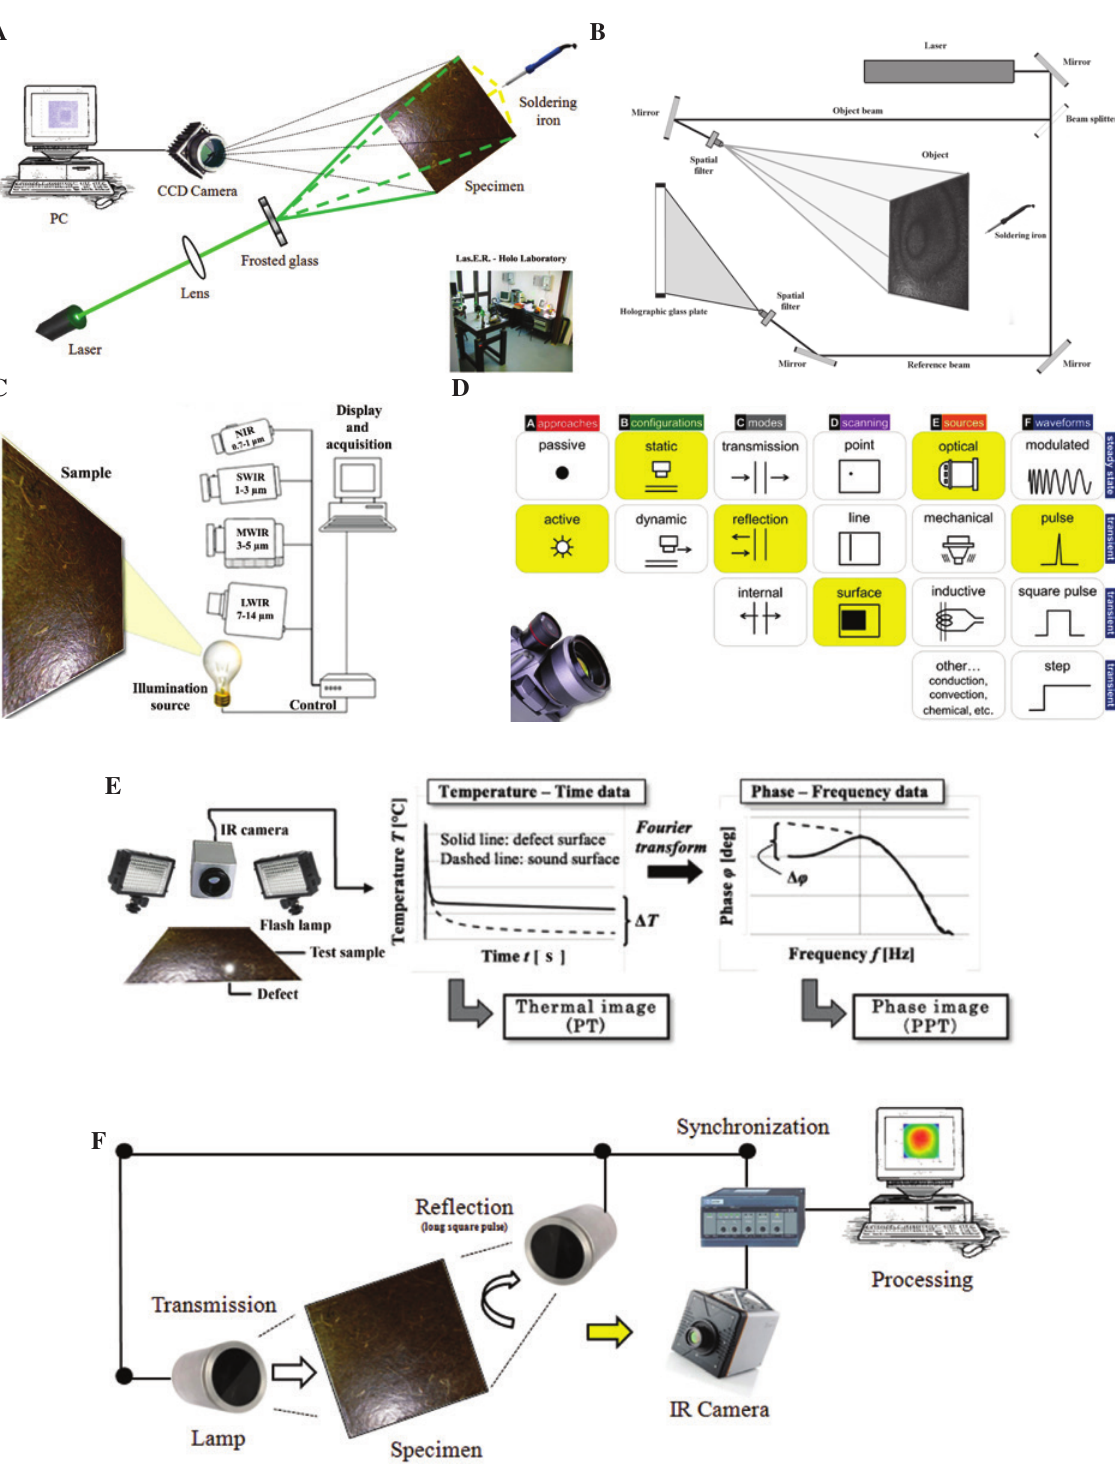
Figure 1 (A) Experimental setup for digital speckle photography (DSP), (B) experimental setup for double-exposure (DE) holographic Inter- ferometry (HI), (C) experimental setup for NIR-SWIR-MWIR-LWIR, (D) classical optical pulsed thermography (PT) [49], (E) inspection and data processing procedure in the pulsed phase thermography (PPT), (F) experimental setup for square pulse thermography